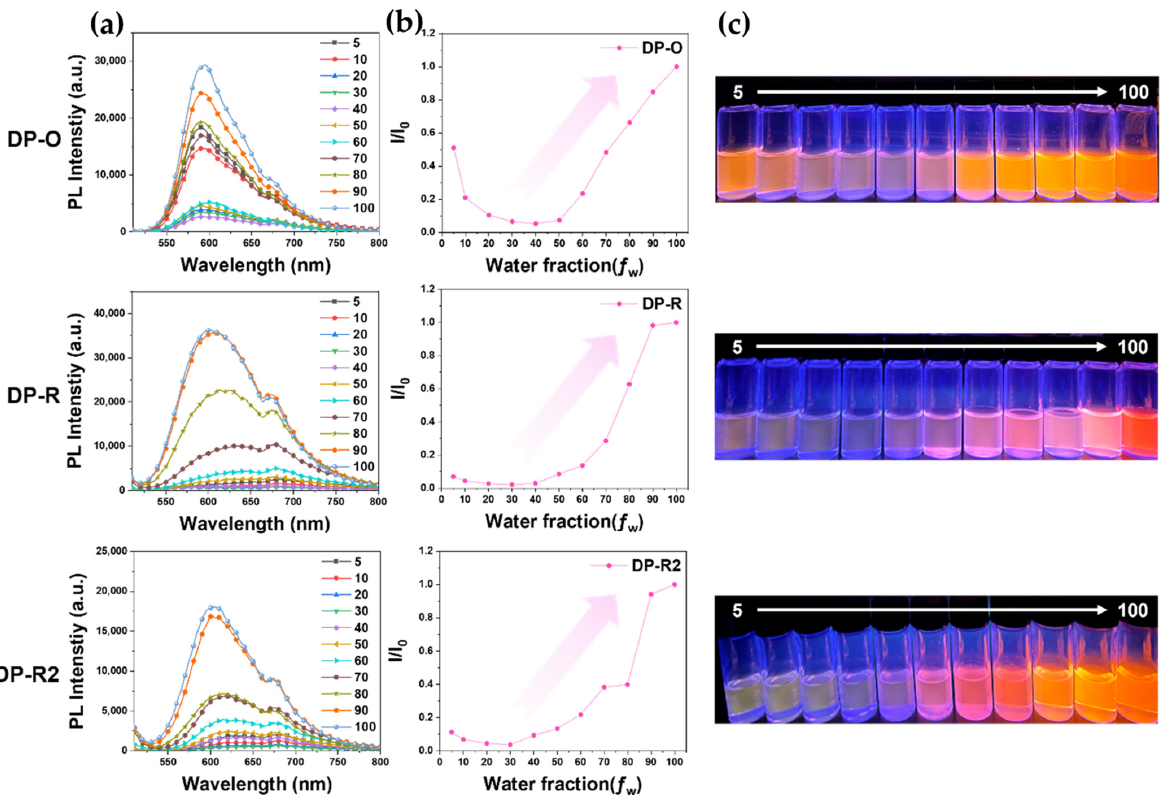
Figure 8. ( a ) PL spectra, ( b ) intensity change of maximum emission wavelength, and ( c ) photographs by water fraction ( f w ) of DPP ‐ based AIE NPs. (Excitation wavelength = 365 nm).